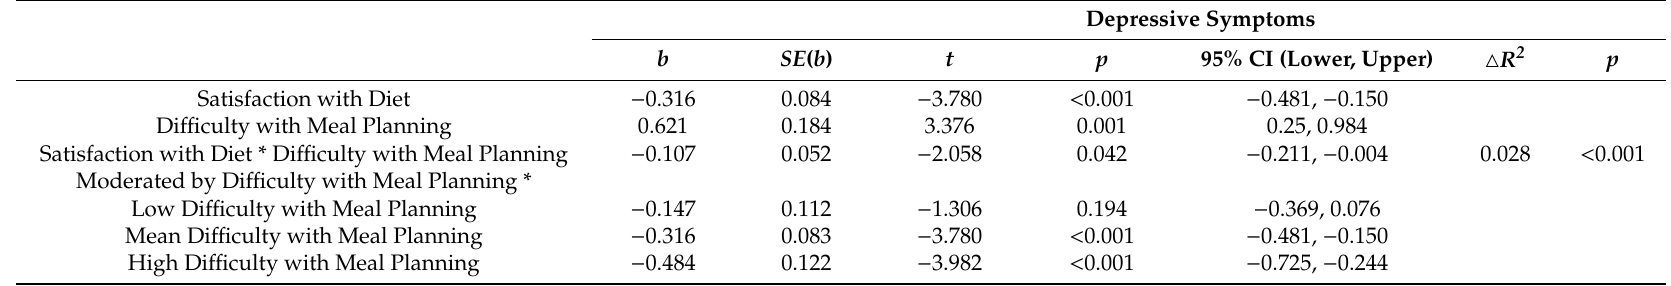
Table 3. Moderating e ff ect of di ffi culty with meal planning in the relationship between satisfaction with diets and depressive